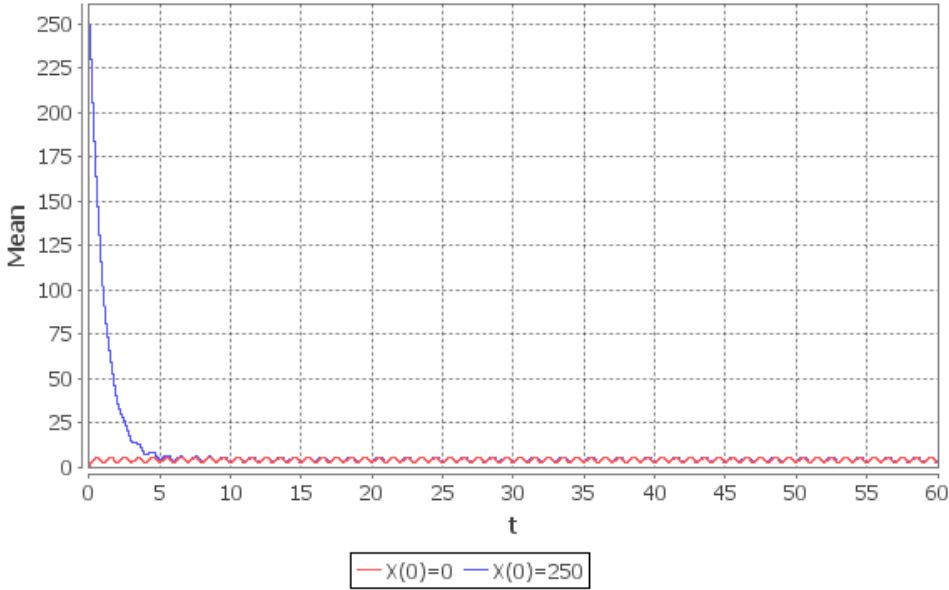
Figure 7. Rate of convergence of the conditional mean E ( t , k ) number of customers in the system in the interval [ 0,60 ] : E ( t ,0 ) ( red line ), E ( t ,250 ) ( blue line ).